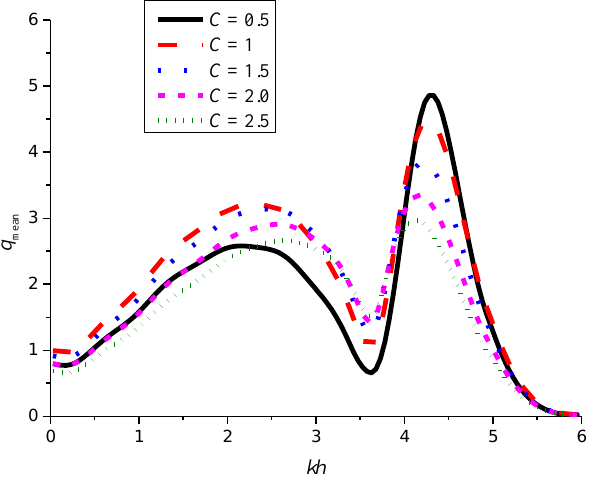
Figure 15. Variations of q mean vs. kh for the WEC array with various PTO damping.